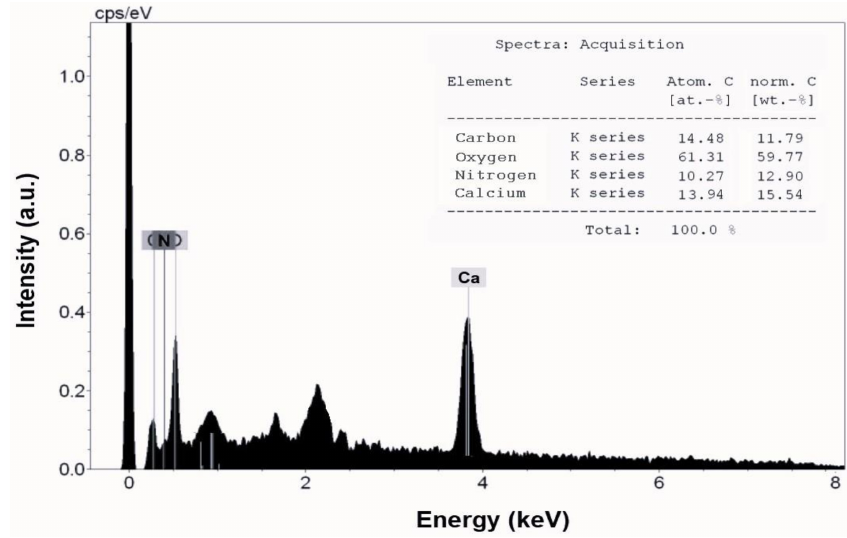
Figure 5. EDS of the chitosan–CaO nanocomposites (15